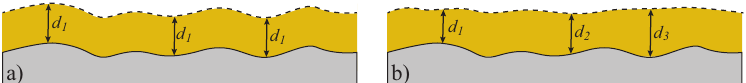
Figure 1. Polymer thin film (yellow) on a silicon substrate (grey) with: ( a ) correlated roughness and therefore a homogeneous layer thickness ( d 1 ) and ( b ) uncorrelated roughness and different layer thicknesses at three positions ( d 1 < d 2 < d 3 ) .